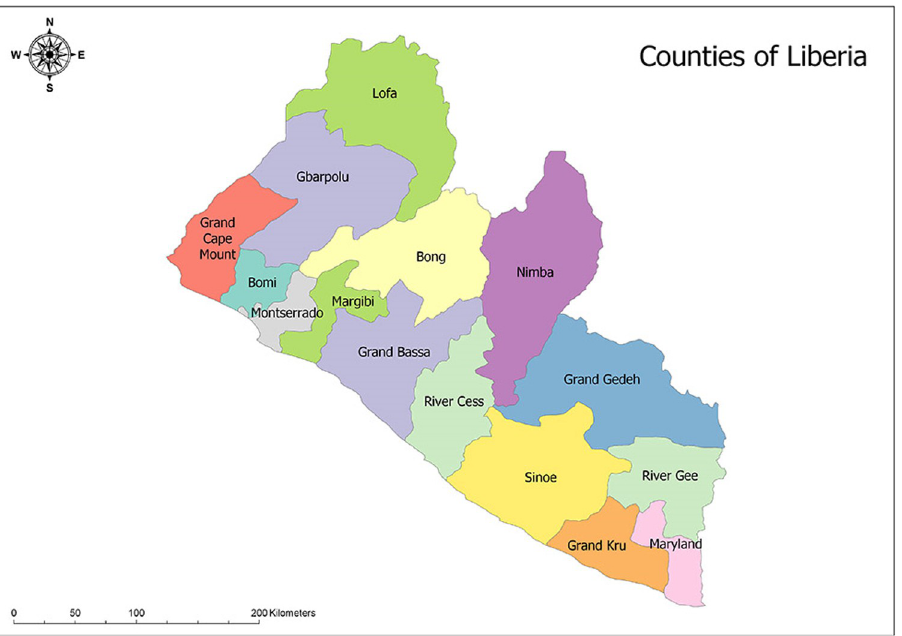
Fig 1. Counties of Liberia; Source: http://www.mapsopensource.com/liberia-counties-map.html.